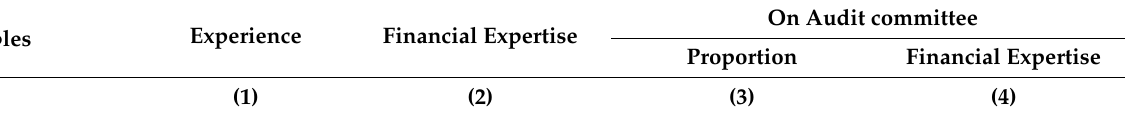
Table 6. Independent female directors characteristics and their effect on financial fraud (marginal